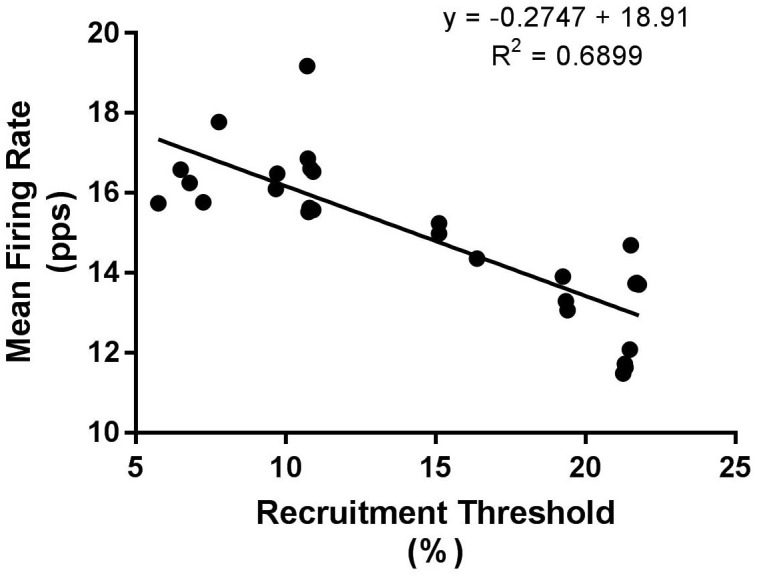
Example linear regression line for the relationship between motor unit mean firing rate and recruitment threshold for a single subject.